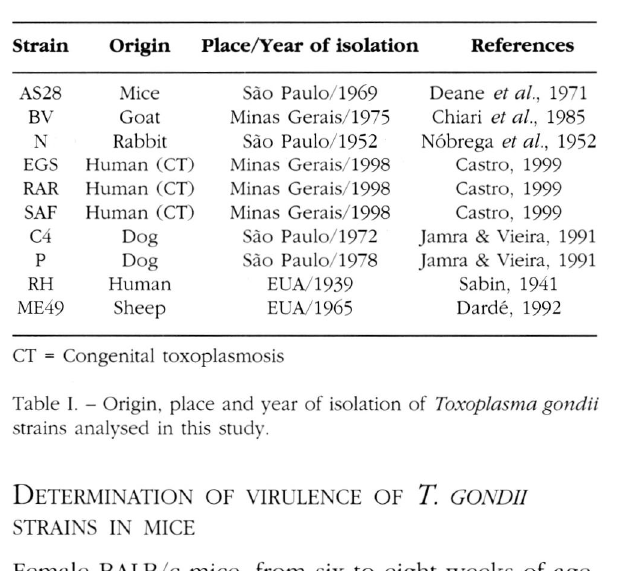
DETERMINATION OF VIRULENCE OF T. GONDII STRAINS IN